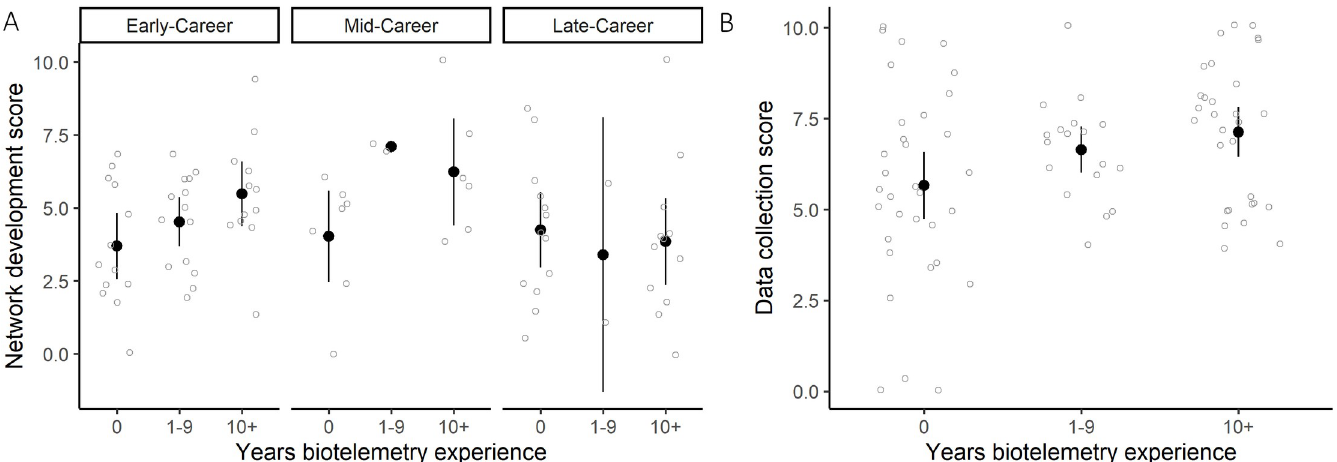
Fig 4. Variation in individual scores (light grey) and mean ± 95% confidence limits of respondent scores (black) A) by age group and years of biotelemetry experience for the PCA component relating to potential involvement in the development of a network by contributing to analytical or technological development or performing meta-analyses on the data, and B) by years of biotelemetry experience for the PCA component relating to potential involvement in collecting data using the network, by deploying transmitters, receivers, or open